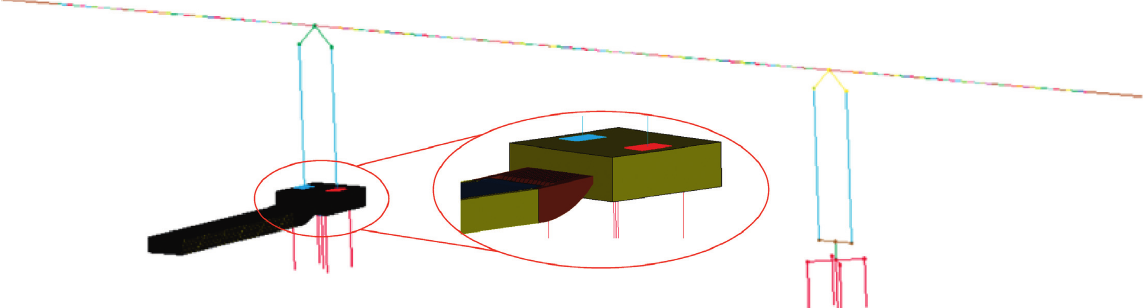
Figure 16: Finite element method model of barge-continuous rigid-frame bridge collision.